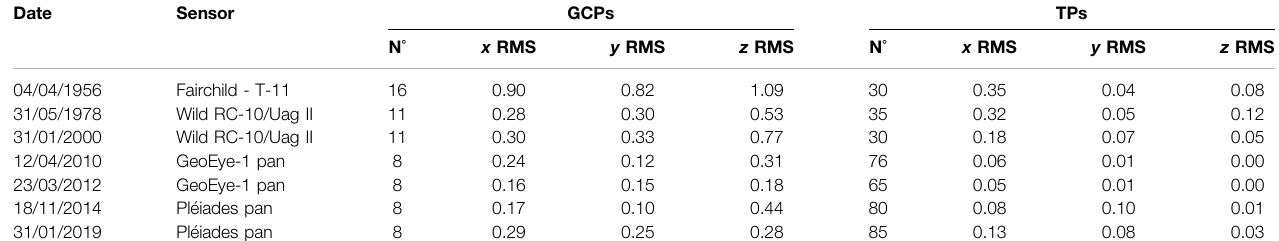
TABLE 2 | Bundle block adjustment parameters included the number (N ° ) of ground control points (GCPs) and tie points (TPs) employed and the RMS error in x , y and z directions (m) for each date.